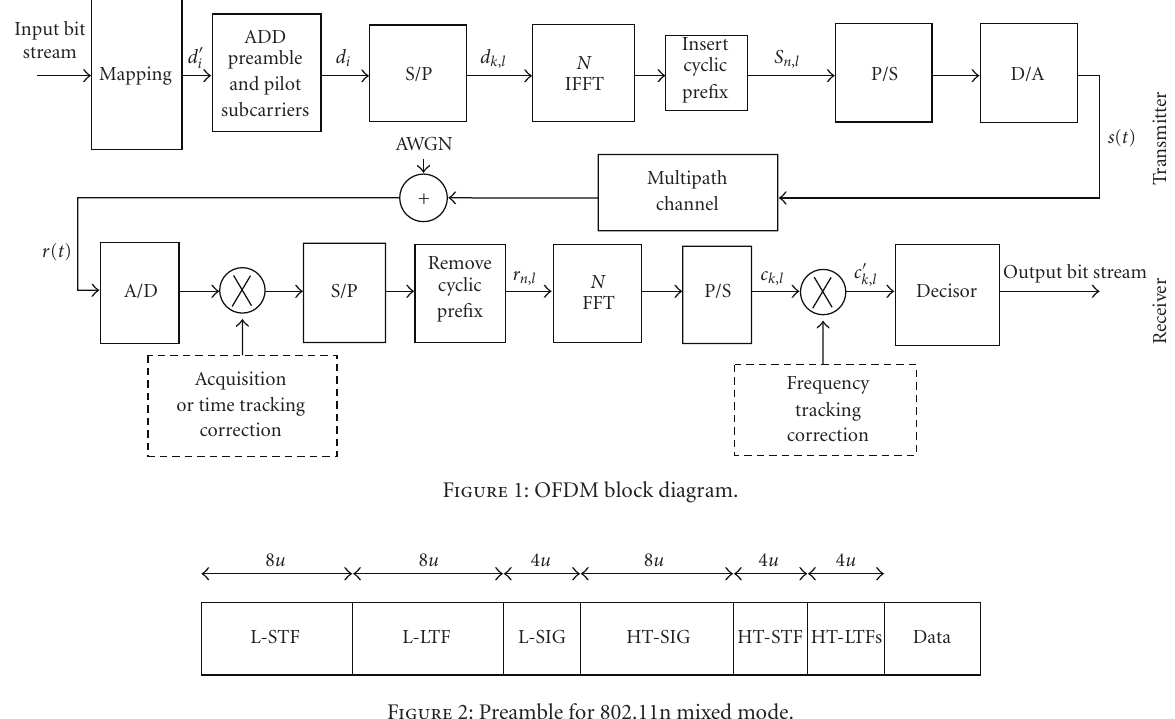
Figure 2: Preamble for 802.11n mixed mode.